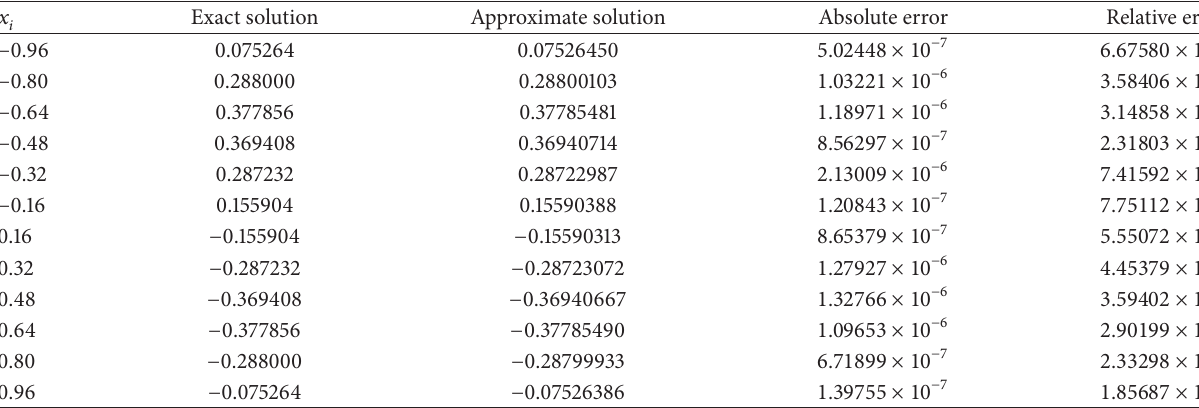
Table 2: Numerical results and errors for Example